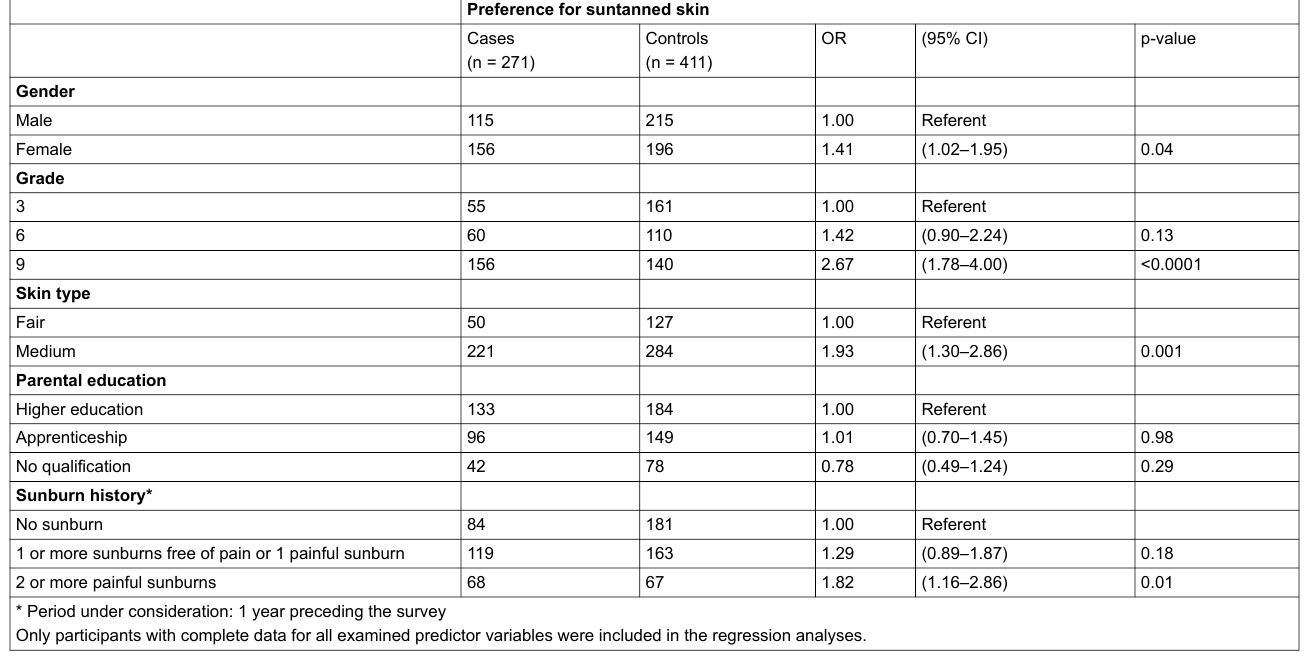
Table 3: Multivariate logistic regression analysis for the preference for suntannend skin. Controls: Preference for untanned skin or no preference for either untanned or tanned skin.